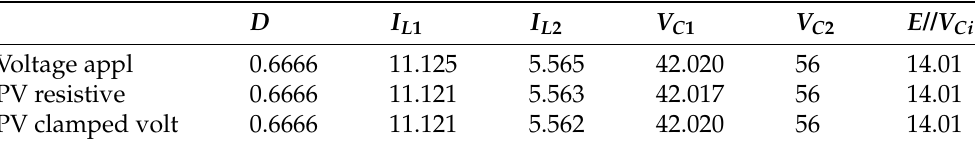
Table 4. Nominal operating point of the proposed converter.